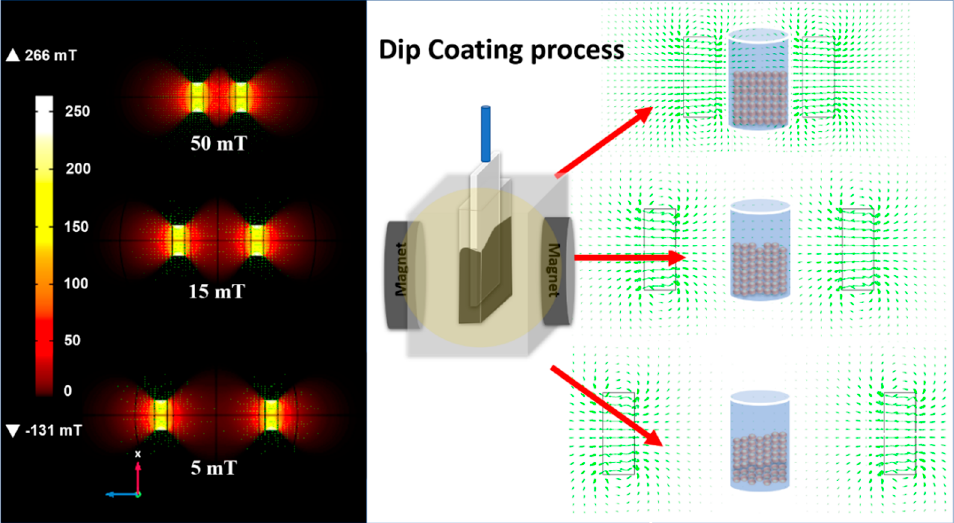
Figure 1. Magnetic field simulation applied in the process of deposition of the magnetite nanopar- ticles by